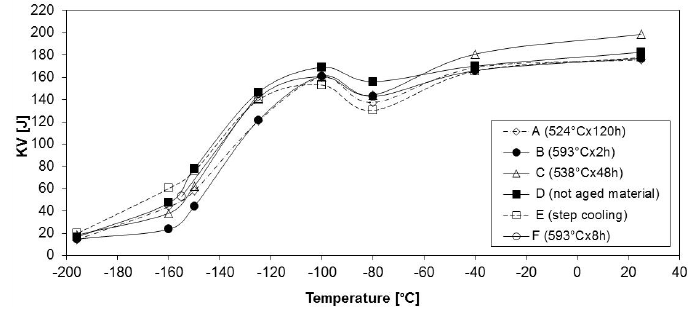
Figure 2. Ductile ‐ brittle transition fracture curves. Figure 2. Ductile-brittle transition fracture